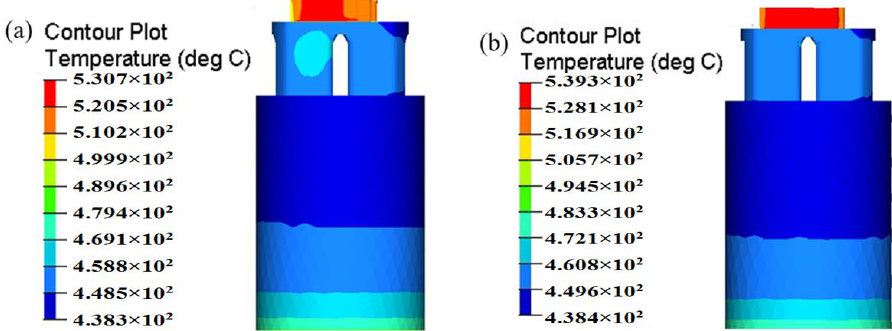
Figure 18. Comparison of the temperature distribution of billet ( a ) the initial die and ( b ) the optimal die.